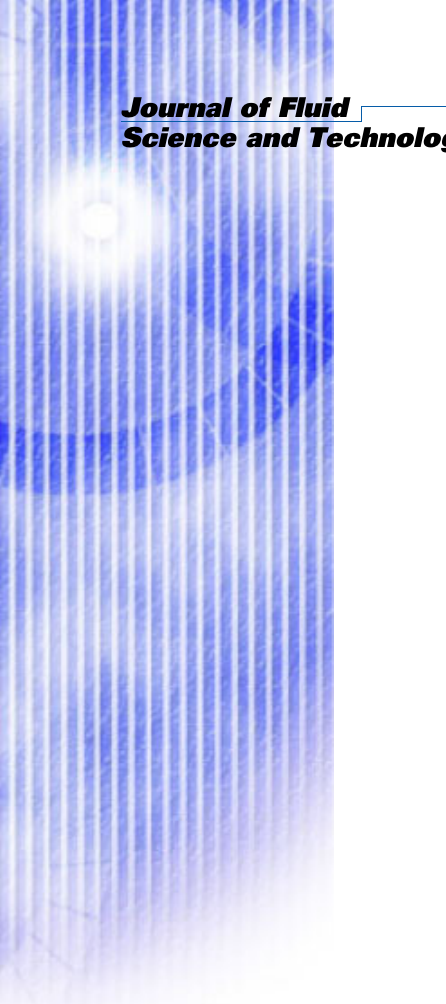
inner surface to the outer surface, when σ is su ffi ciently small as in Fig.2(a), the jet behaves like a single phase column jet and is expected to produce a train of liquid capsules. Whereas for larger σ = 2 . 6 as in Fig.2(b), the inner surface becomes more unstable than the outer surface, which may lead to a train of core liquid drops in the sheath of the annular phase. On